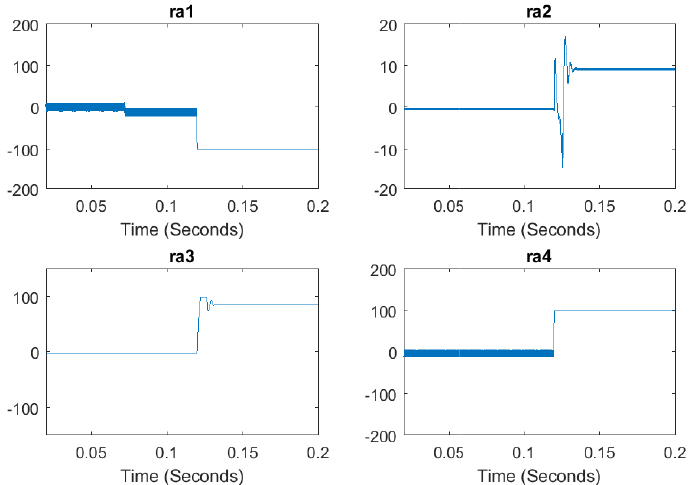
Figure 20. Simulation of residuals in the case of transistor Q 1 (m11)